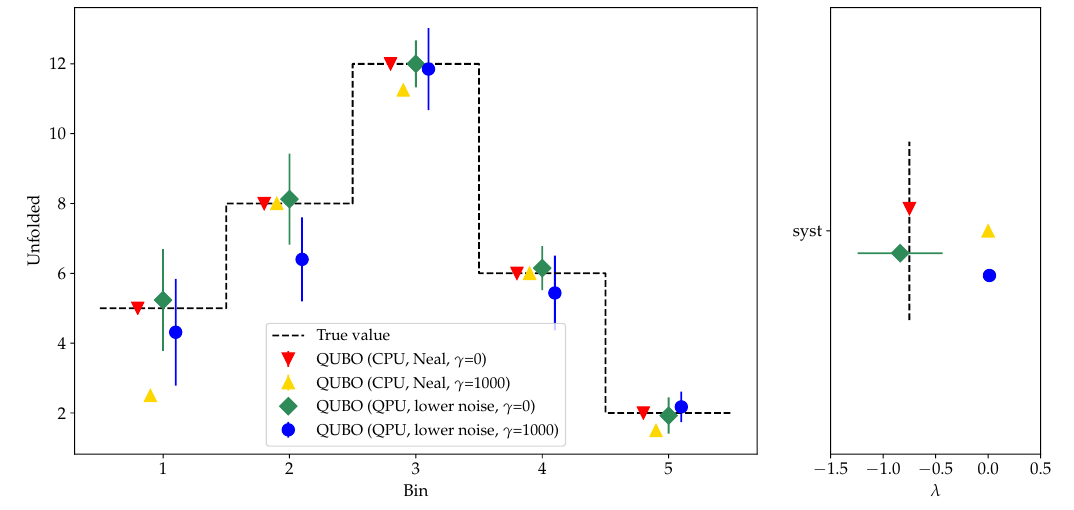
Figure 5 . Truth-level distribution of pseudo-data, unfolded with di(cid:11)erent methods, of a peaked spectrum including the e(cid:11)ect of a shape systematic. The data corresponding to runs submitted to the QPU are averaged over 20 executions with 5000 reads